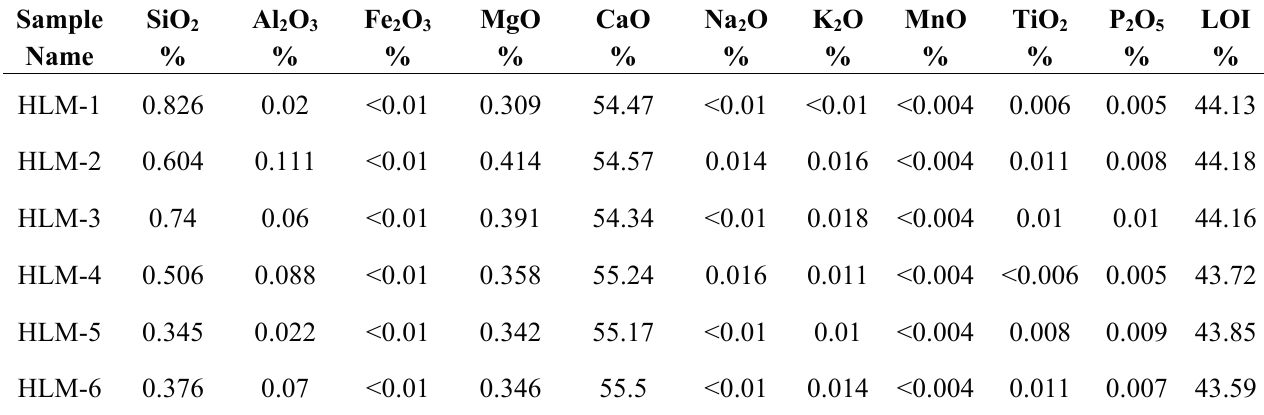
Table 2. Quantitative chemical composition analysis by X-ray fluorescence analysis (in % by wt.).